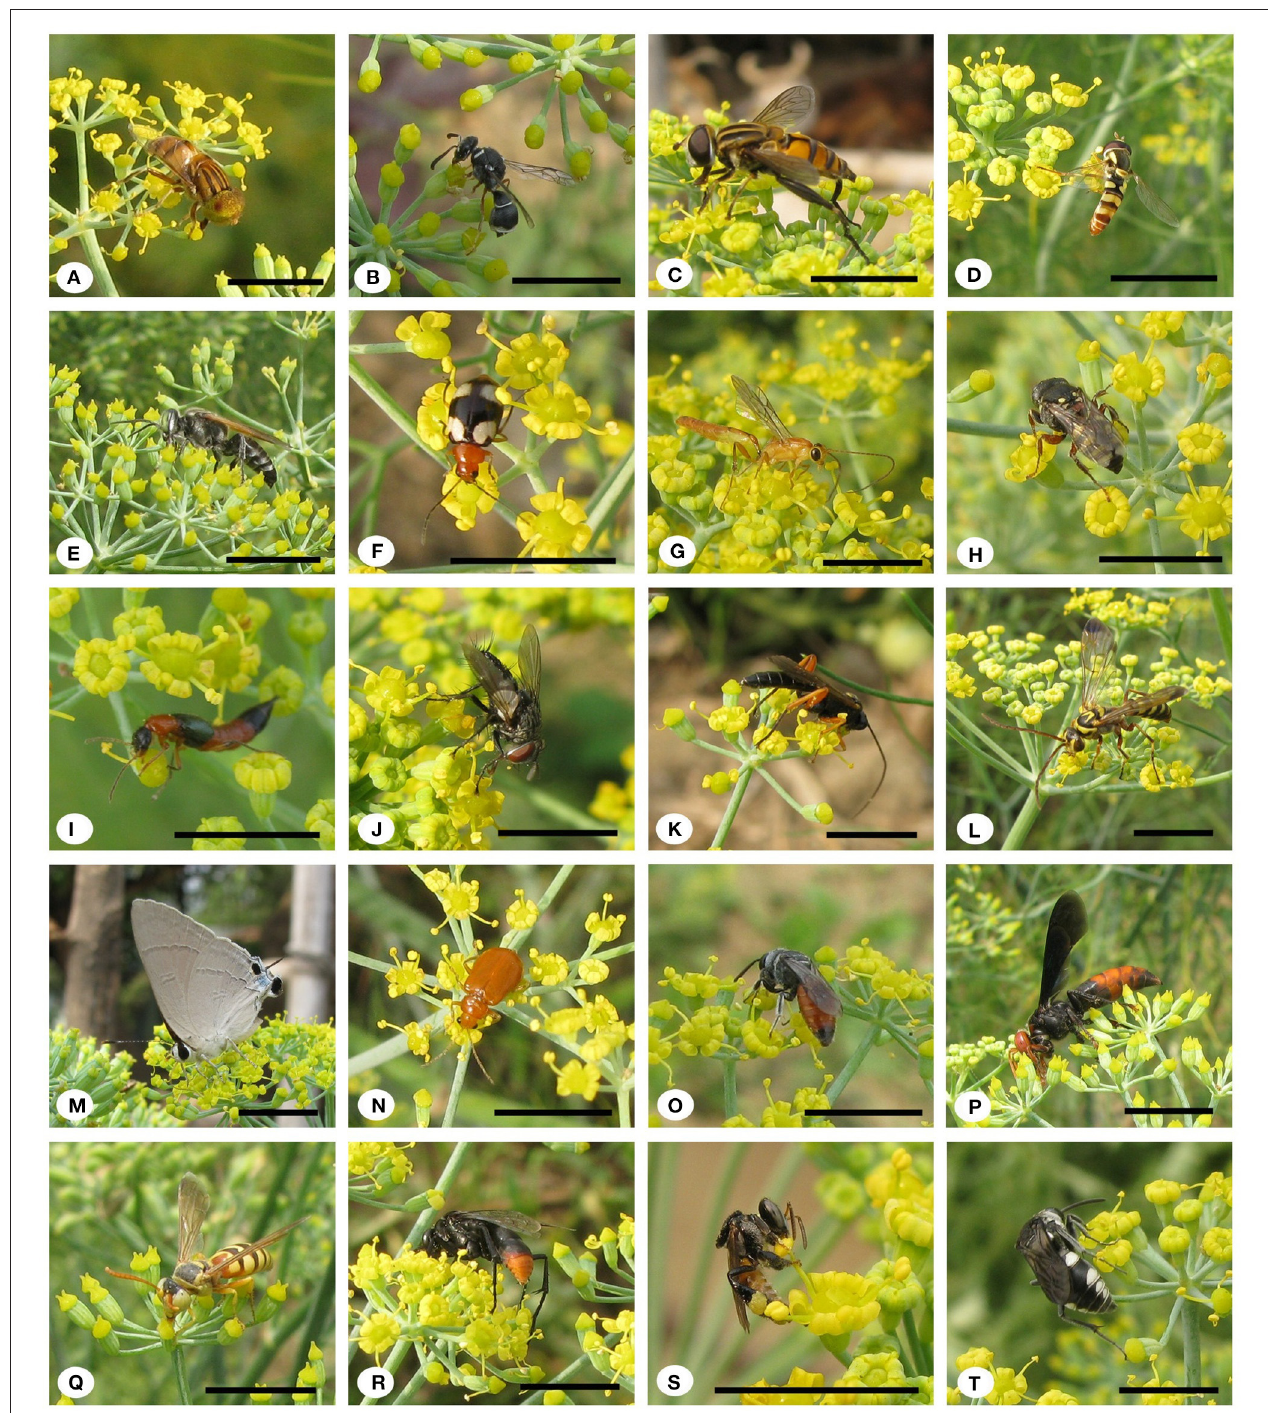
FIGURE 3 | Floral visitors of fennel in West Bengal. (A) Eristalinus megacephalus , (B) Eumenes fraternus , (C) Helophilus peregrinus , (D) Ischiodon scutellaris , (E) Liris aurata , (F) Monolepta signata , (G) Ophion obscuratus , (H) Oxybelus furculatus , (I) Paederus fuscipes , (J) Pelatachina tibialis , (K) Pimpla rufipes , (L) Poecilopompilus interruptus , (M) Rapala manea , (N) Raphidopalpa foveicollis , (O) Sphecodes gibbus , (P) Stizoides crassicornis , (Q) Stizus ruficornis , (R) Tachypompilus analis , (S) Tetragonula iridipennis , and (T) Thyreus nitidulus . Scale bar = 10mm.